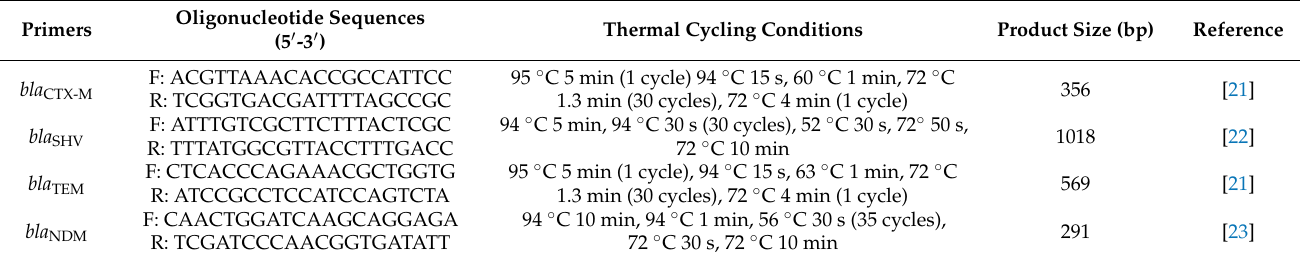
Table 1. Primers used for the amplification of ESBL and metallo- β -lactamase gene. Oligonucleotide Sequences Thermal Cycling Conditions Product Size (bp) Primers (5 (cid:48) -3 (cid:48) )